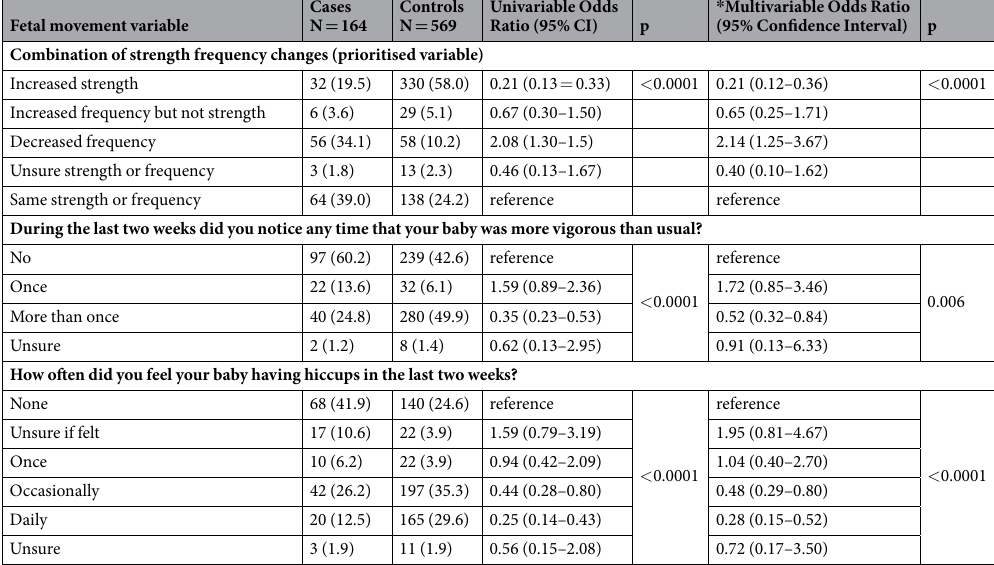
Table 3. Multivariable analysis of strength and frequency of fetal movements, and odds of late stillbirth. Data are n (%). * Adjusted for parity, employment, body mass index, fetal sex, and gestation. All fetal movement variables in the table are included in the model. Where column numbers do not add up to N this is due to missing data.